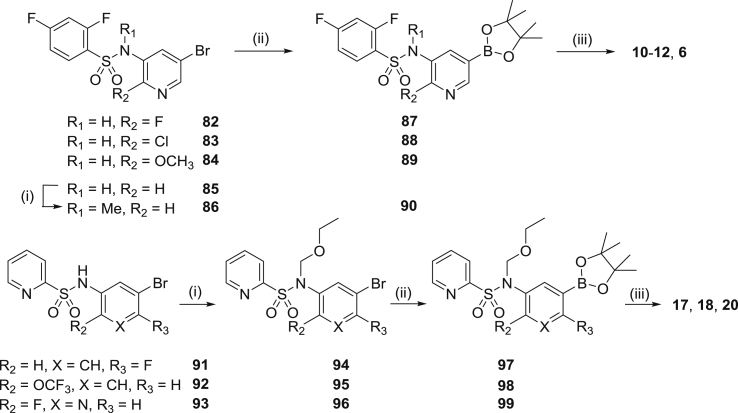
Reagents and conditions: (i) a. NaH, DMF, 0° C, 0.5 h, b. MeI or (chloromethoxy)-ethane, DMF, 0° C-RT, 1.5 h; (ii) Bis(pinacolato)diboron, KOAc, Pd(dppf)Cl2, DMSO, 90 °C, 3 h.; (iii) a. 75, Pd(dppf)Cl2, EtOH/toluene, 2 M Na2CO3, reflux, b. Deprotection if required: 3 M HCl/1,4-dioxane (1:1), 1 h.